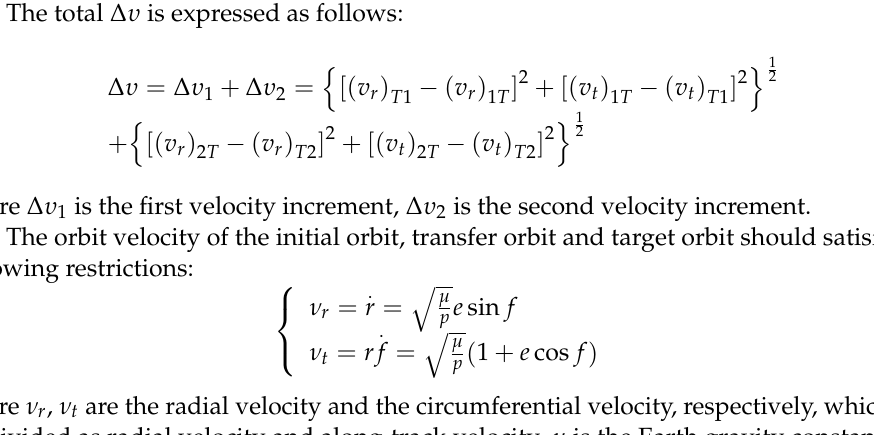
Figure 15. Schematic diagram of dual-impulse symmetrical control.